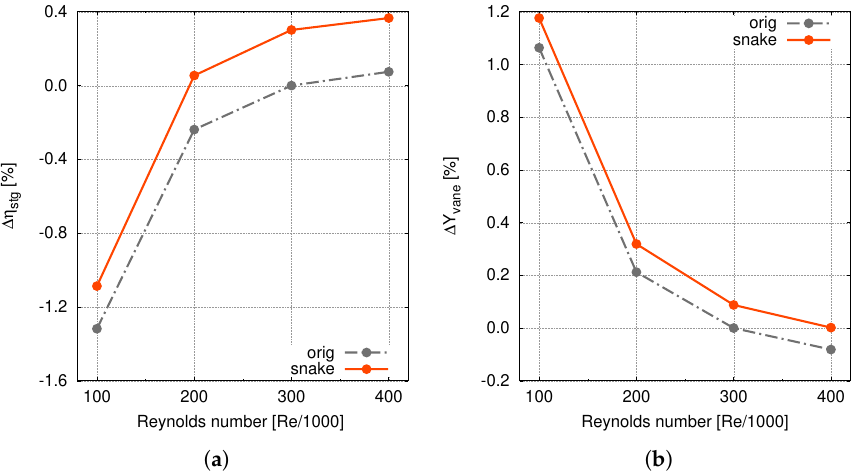
Figure 7. Performance of the “snaked” blade at varying Reynolds number: ( a ) stage efficiency; ( b ) vane